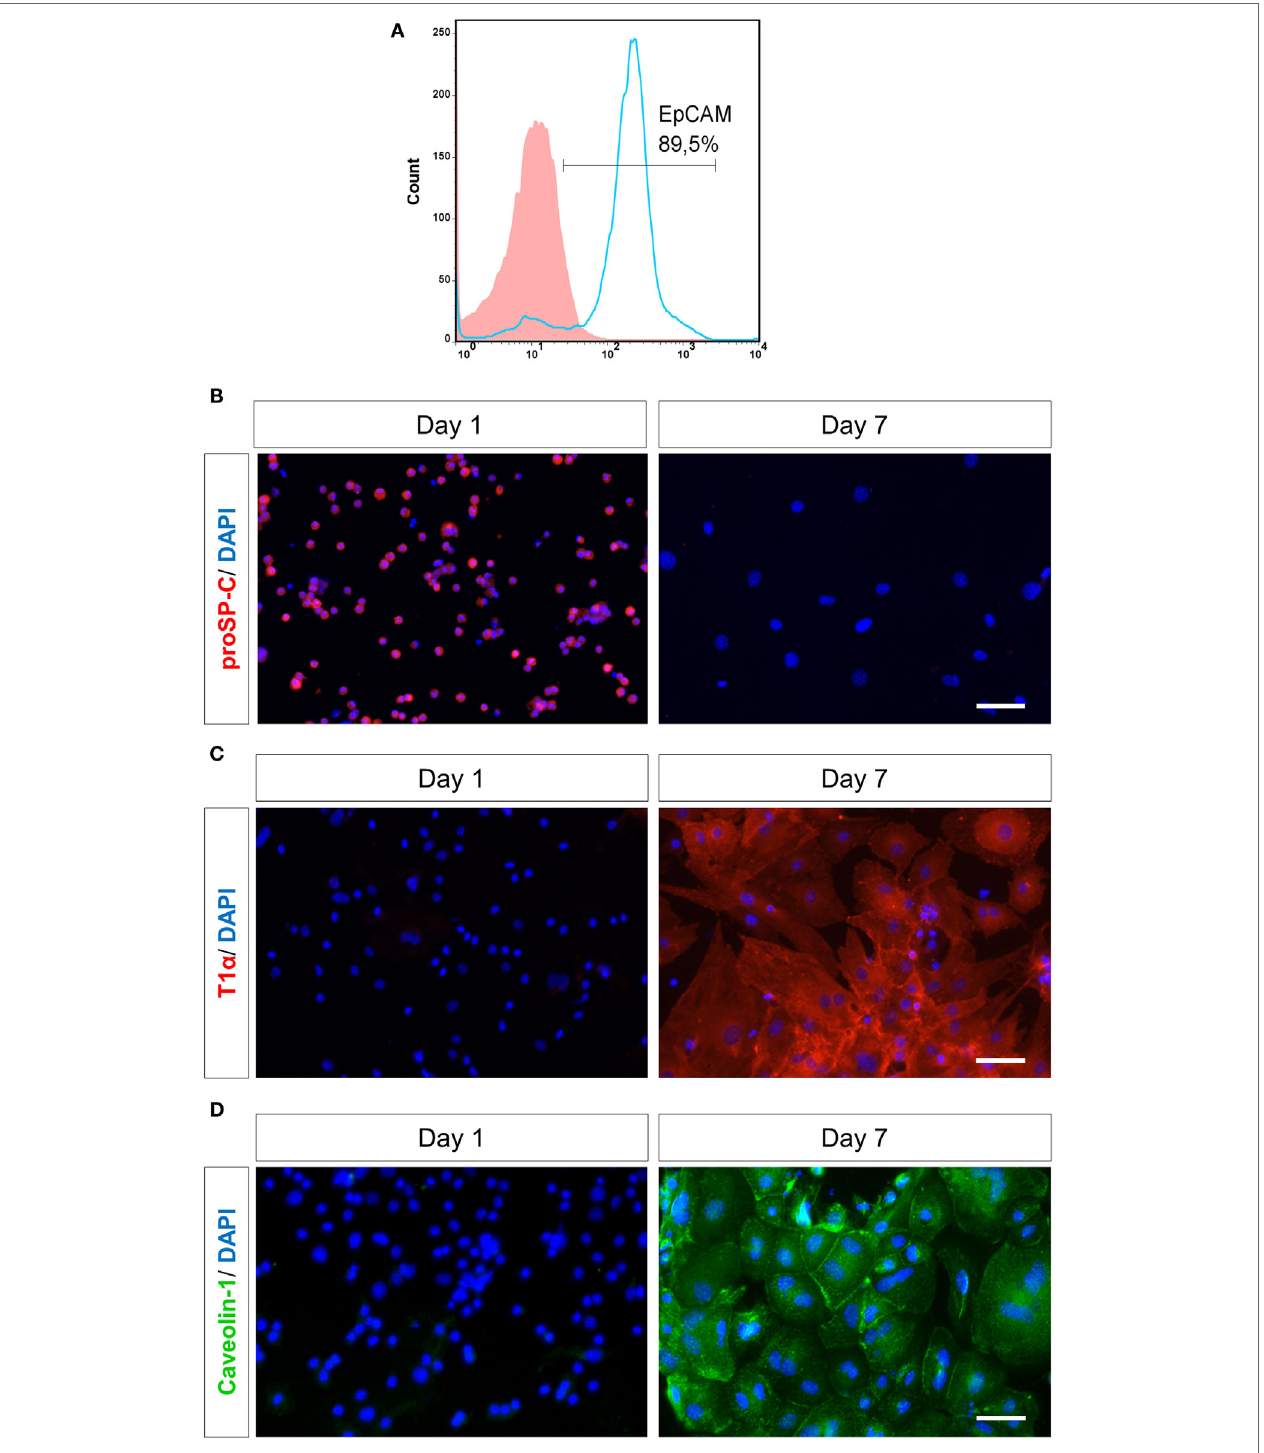
FigUre 1 | Purity and characterization of murine alveolar epithelial cells (AECs) after isolation. (a) Murine lung cells were stained by flow cytometry for EpCAM (APC) after negative magnetic bead purification and plating on Petri-dishes for 4 h. Solid histogram depicts isotype control, open histogram depicts EpCAM staining. EpcAM, epithelial cell adhesion molecule; APC, allophycocyanin. AECs were characterized based on staining for various cell surface markers, like (B) AECII-specific marker proSP-C (Texas red), (c) AECI-specific marker T1 α (Texas red) and (D) AECI-specific marker Caveolin-1 (FITC) on day 1 or 7 after seeding. Nuclei were stained with DAPI. Imaging was performed by an inverted fluorescent microscope (Axio Observer, Zeiss). Scale bars are 50 µm. proSP-C, prosurfactant protein C; FITC, fluorescein